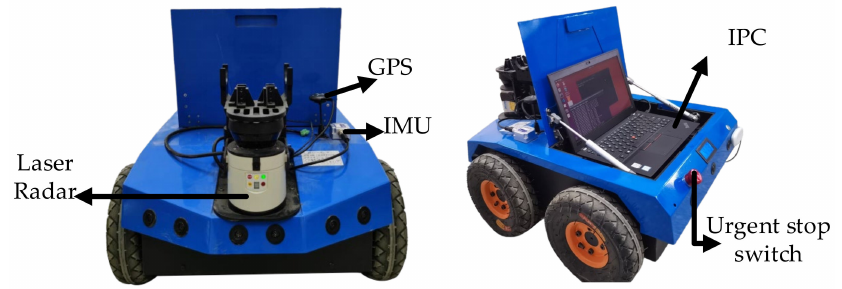
Figure 2. WPV4 all-terrain